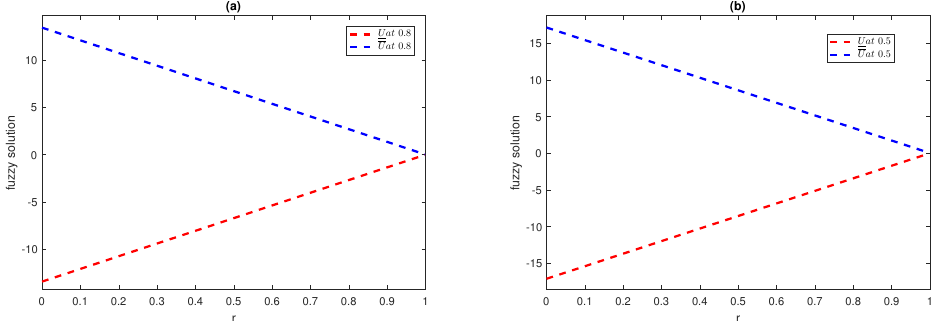
Figure 5. 3-D fuzzy upper and lower part simulation of semi-analytical series solution up to first four terms at τ = t = 0.5, x 2 = y = 0.5, and at θ = 0.5,0.8, for Example 3.